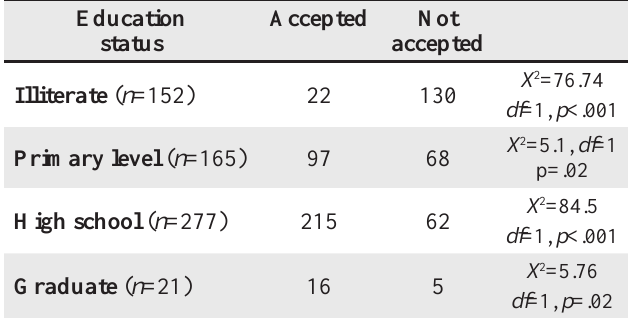
Table 3 : Education status and acceptance of contraception in wives